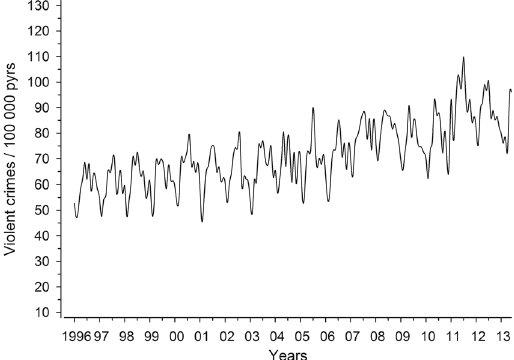
Figure 1. The incidence of violent crime per 100,000 person years in Finland between January 1996 and December 2013.